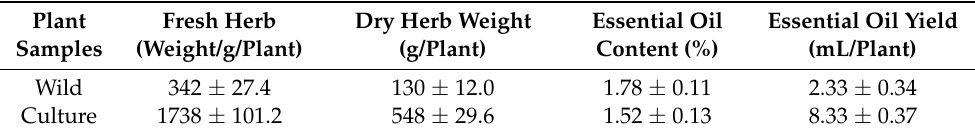
Table 1. Fresh and dry herb weights, EO ratios, and yields of wild and cultivated E. tenuifolia subsp. sibthorpiana